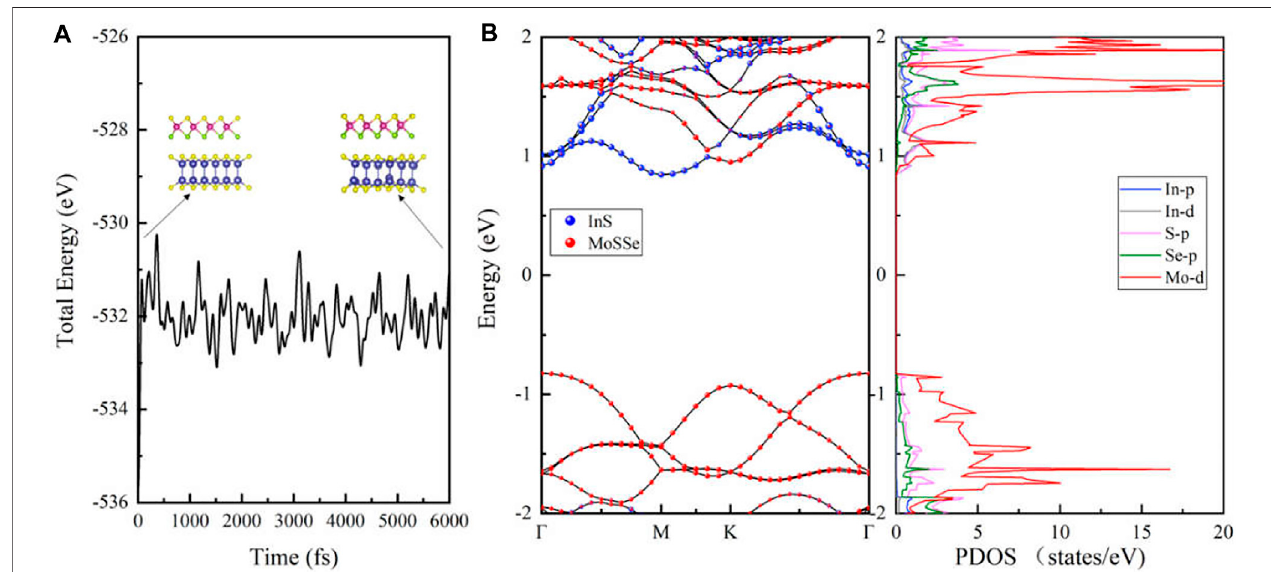
FIGURE3|(A) ThetotalenergyandthecrystalstructurescalculatedfromtheAIMDoftheMoSSe/InSevdWH. (B) TheprojectedbandstructuresandthePDOSof the MoSSe/InS vdWH.